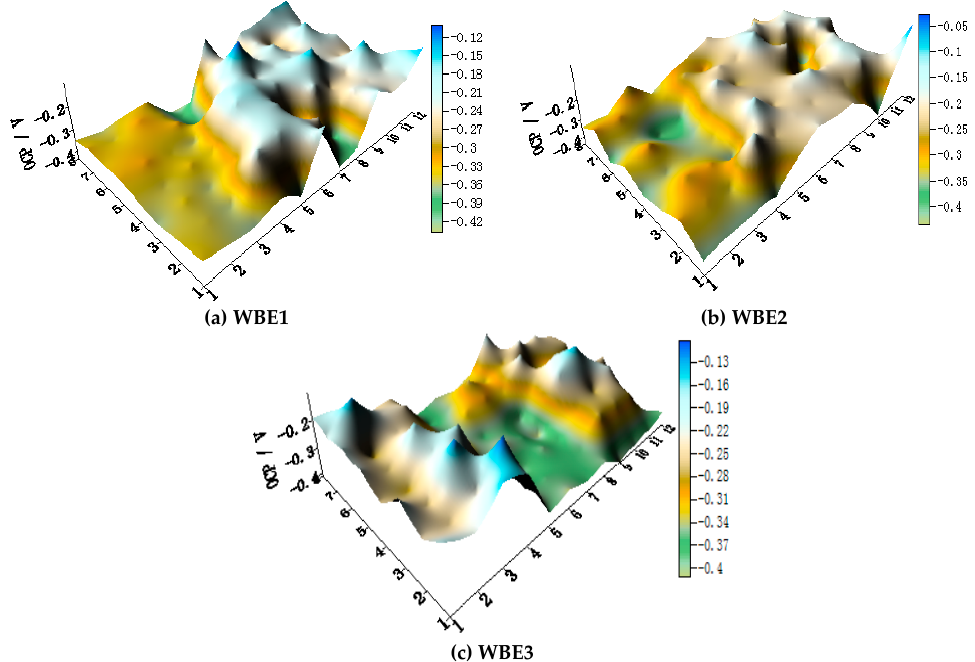
Figure 15. OCP (vs. SCE/V) distribution maps of three coupled electrodes after immersion in artificial seawater: 1.5% (Cl − , wt %) and 30 °C: ( a ) WBE1, HAl77-2/316L SS/TA2; ( b ) WBE2, HAl-77-2/TA2/316L artificial seawater: 1.5% (Cl − , wt %) and 30 ◦ C: ( a ) WBE1, HAl77-2/316L SS/TA2; ( b ) WBE2, SS; and ( c ) WBE3, TA2/HAl77-2/316L SS. HAl-77-2/TA2/316L SS; and ( c ) WBE3, TA2/HAl77-2/316L SS.